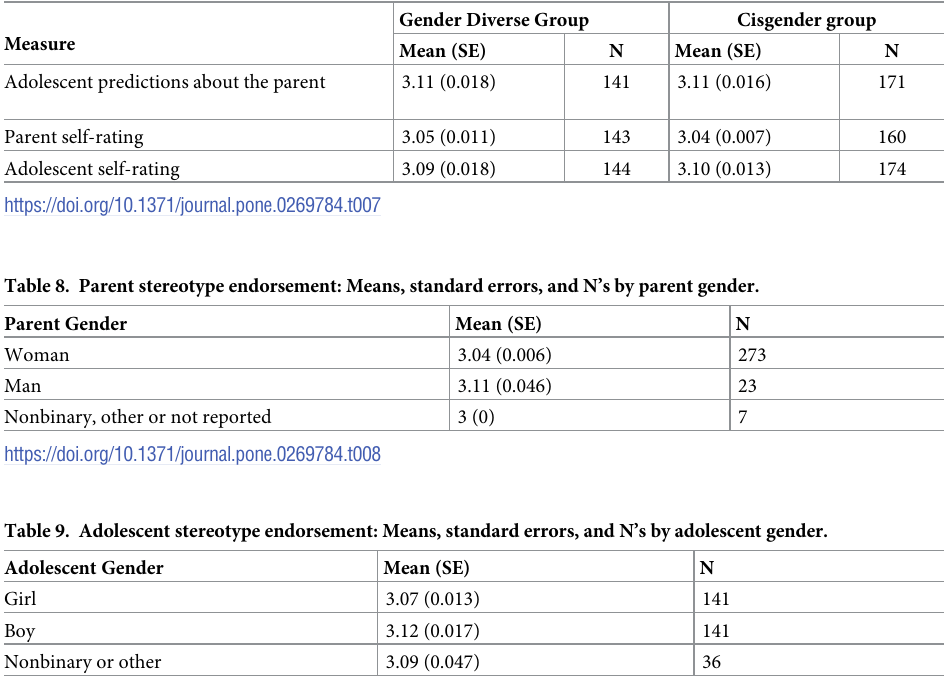
Table 7. Means, standard errors, and N’s by participant group and measure.